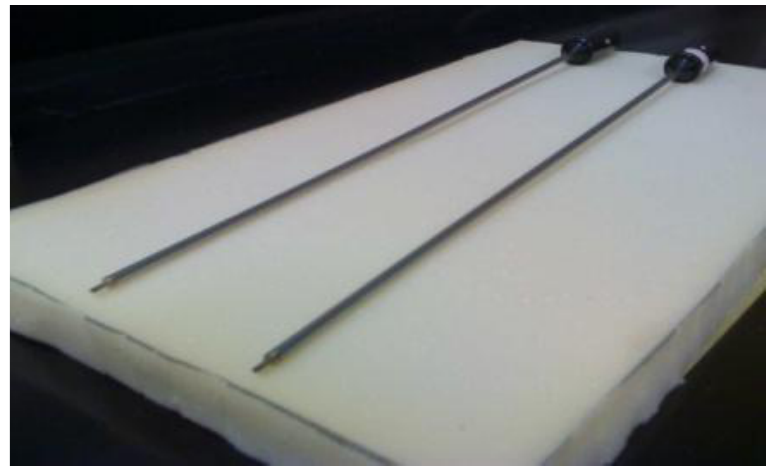
Figure 4. Optical Probe (PV6) System (Institute of Process Engineering of the Chinese Academy of Sciences).